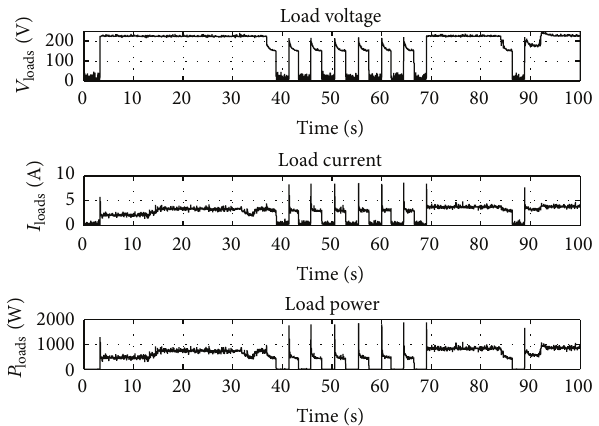
Figure 18: Voltage, current, and power change of loads for case